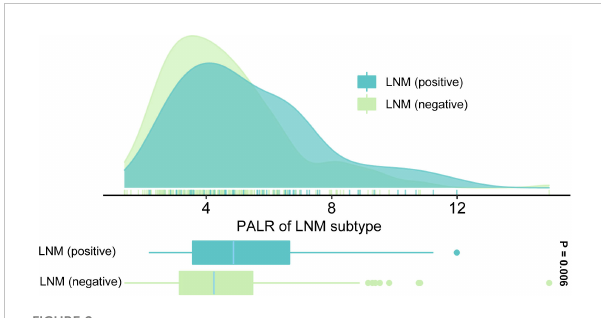
FIGURE 2 Distribution of PALR values in LNM-positive and LNM-negative